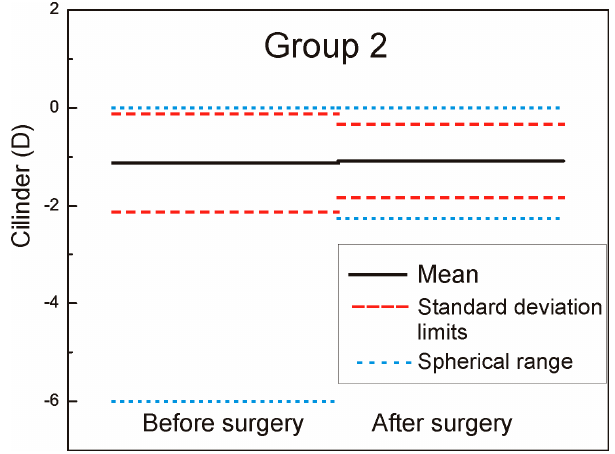
Figure 4. Mean cylinder pre- and postoperative Group 2.